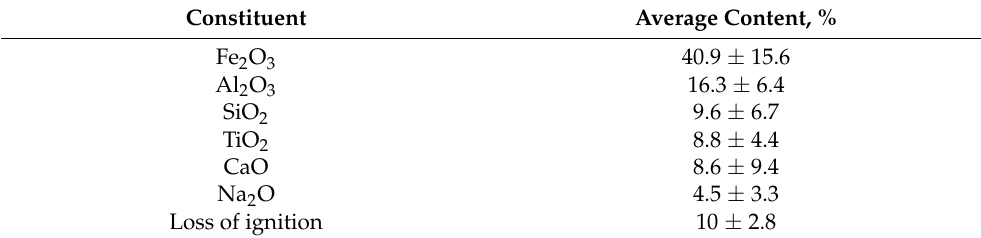
Table 1. Major constituents of bauxite residues [9].